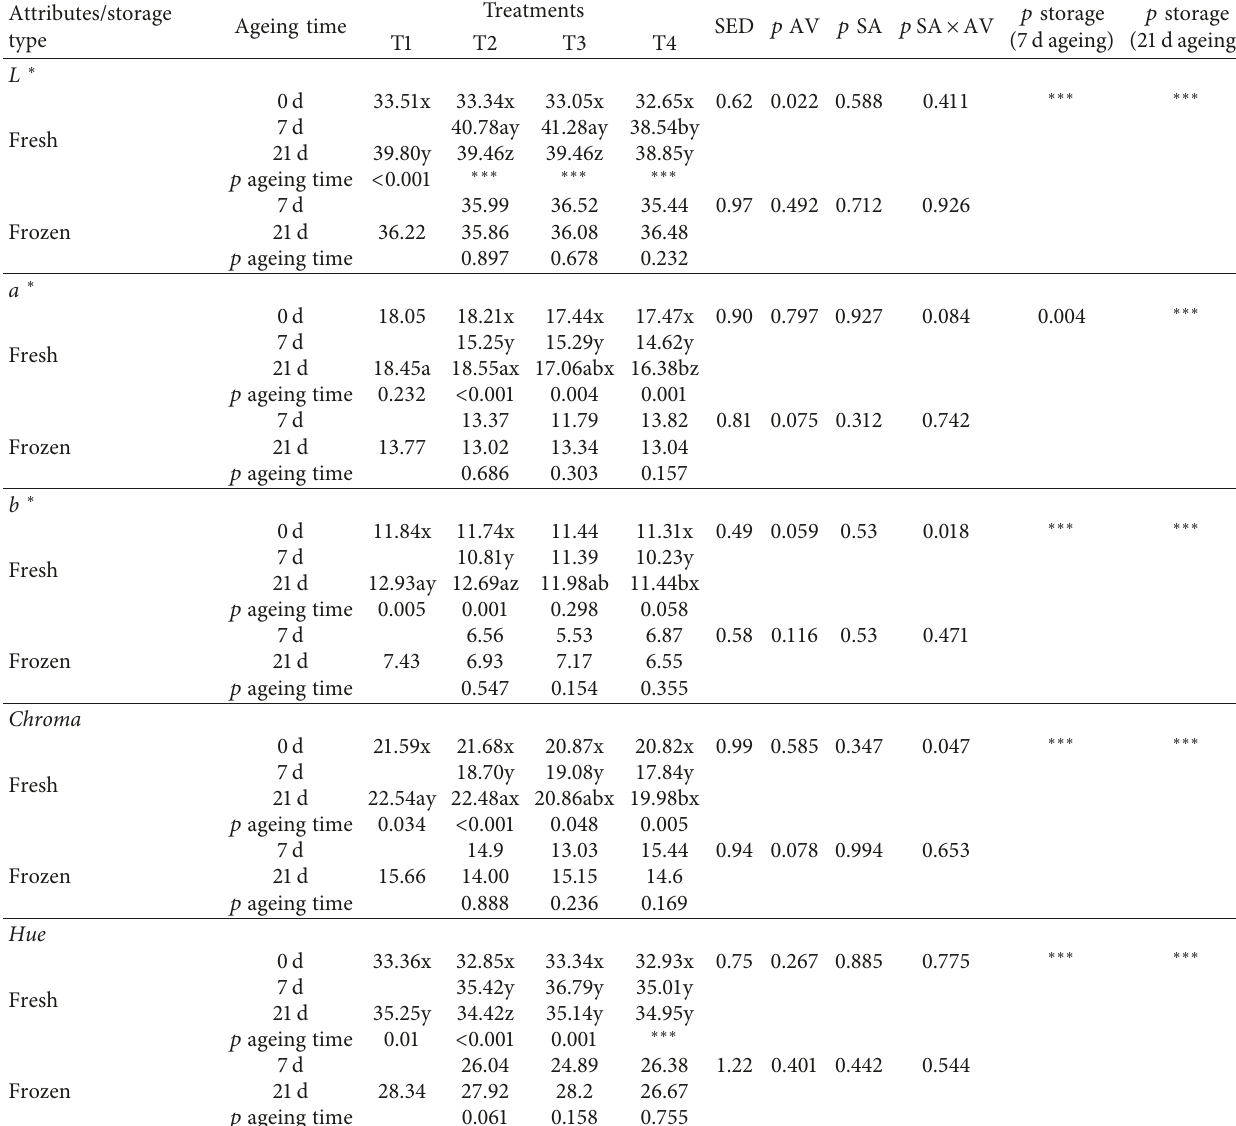
Table 3: Effect of ageing treatments, ageing time, and frozen storage on the instrumental colour of in-bag dry-aged lean bull beef.